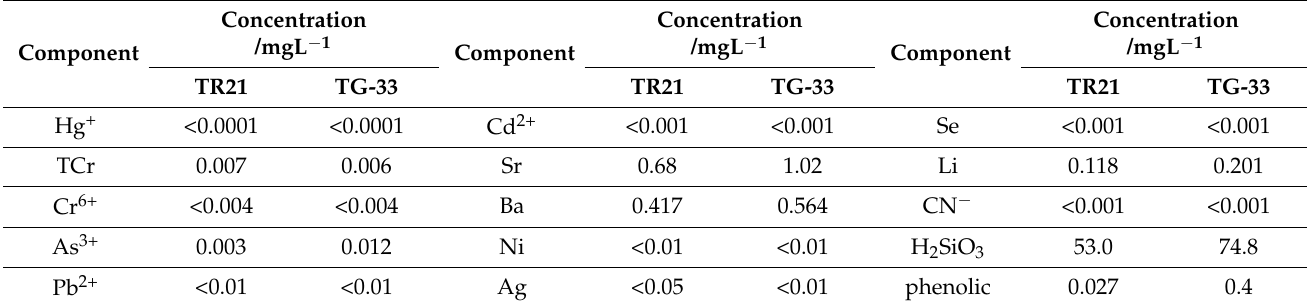
Table 4. Characteristic elements and trace chemical components table of Dongying geothermal fluid.